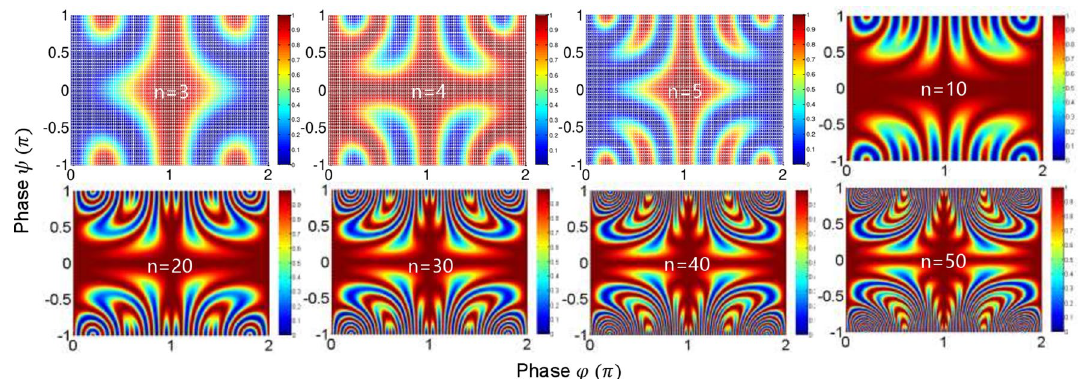
n ) α for different n in Fig.